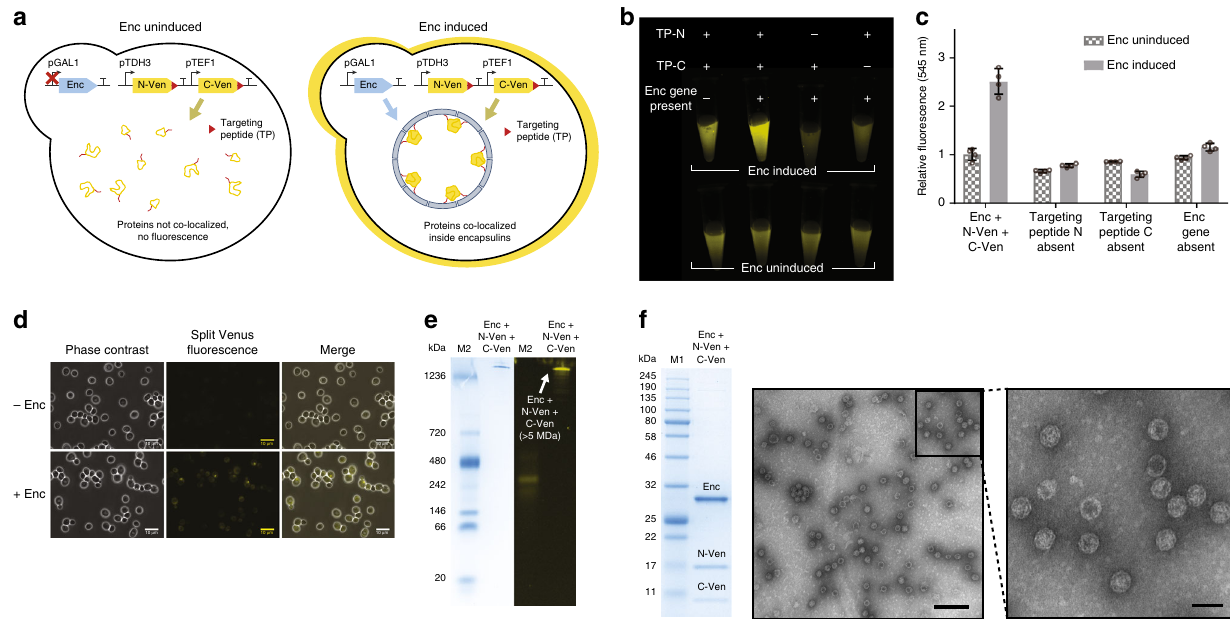
Fig. 3 Protein co-localization and encapsulation in yeast. a Co-encapsulation of split-Venus components led to an increase in fl uorescence intensity as determined by a variety of experimental techniques. b Bulk images of live yeast cells show greater fl uorescence intensity only when both targeting peptides (TPs) are present and the encapsulin gene is present and induced. c Bulk plate-reader measurements indicate a 2.5-fold increase in fl uorescence only with both TPs and encapsulin present. d Fluorescence microscopy of live yeast cells indicates greater fl uorescence only in the presence of encapsulin. Scale bar represents 10 µ m. e Native PAGE analysis with the left side showing a Coomassie-stained gel, and the right side showing fl uorescence imaging of the same gel. The encapsulated split-Venus showed in-gel fl uorescence associated with the high molecular weight assembled encapsulin nanocompartment band seen by Coomassie-staining (Enc + N-Ven + C-Ven). Full gel image is shown in Supplementary Fig. 10. f Puri fi ed encapsulins co-puri fi ed with the split- Venus proteins (N-Ven 19.4/C-Ven 11.6 kDa) by SDS-PAGE, and formed the expected compartments as imaged by TEM. Full gel image is shown in Supplementary Fig. 2. M2 = NativeMark Unstained Protein Standard (ThermoFisher). Error bars represent the standard deviation of four biological replicates. Scale bars: zoom out: 200 nm, zoom in: 50 nm